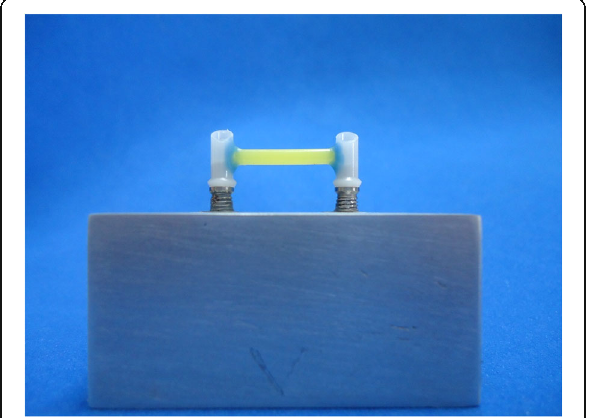
Fig. 1 UCLA casting cylinders attached with wax bar before